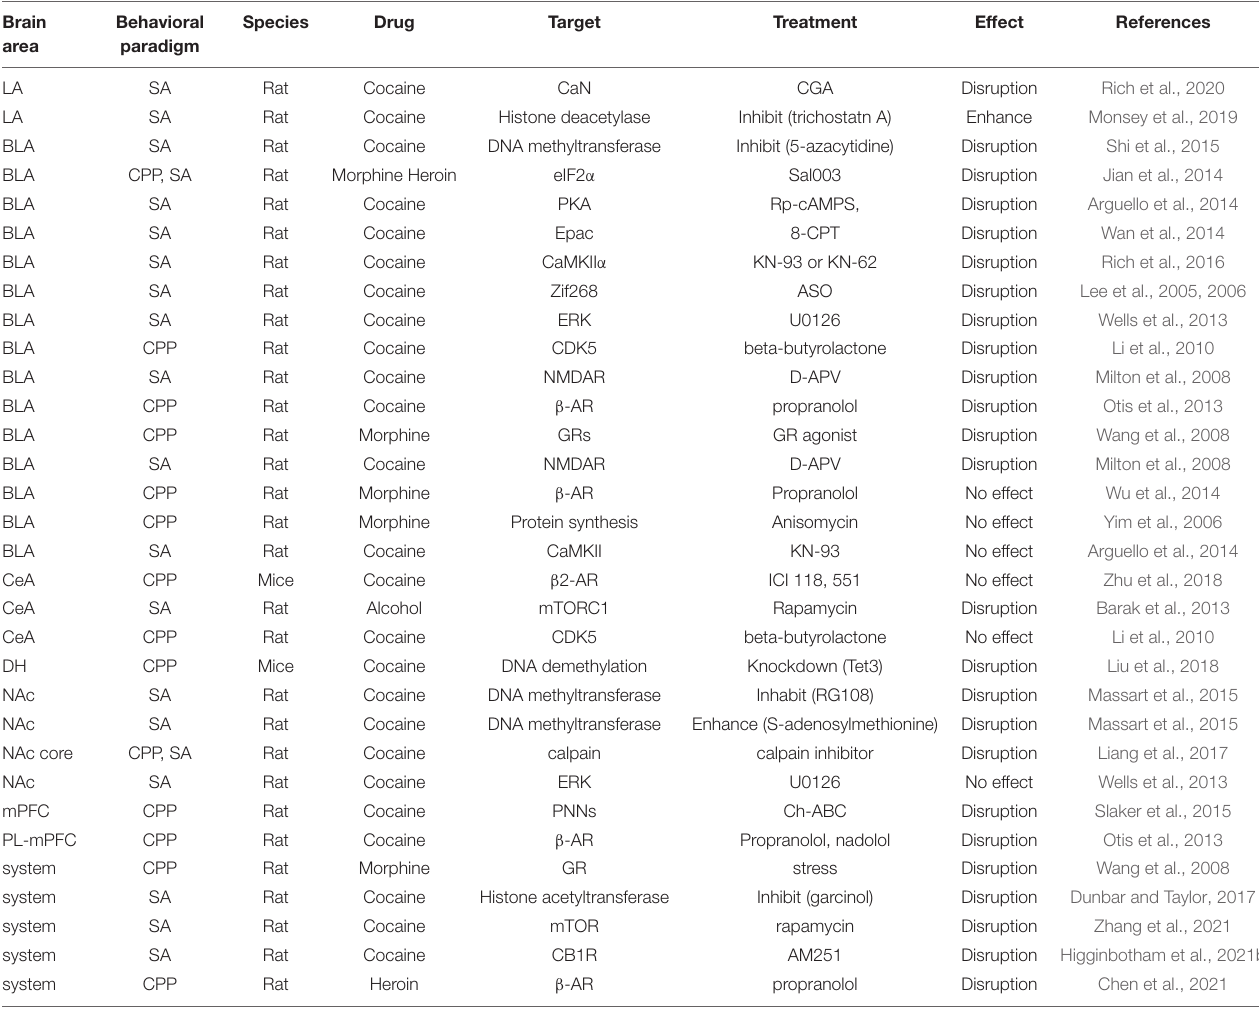
TABLE 1 | Summary of experiments addressing mechanisms of Pavlovian memory